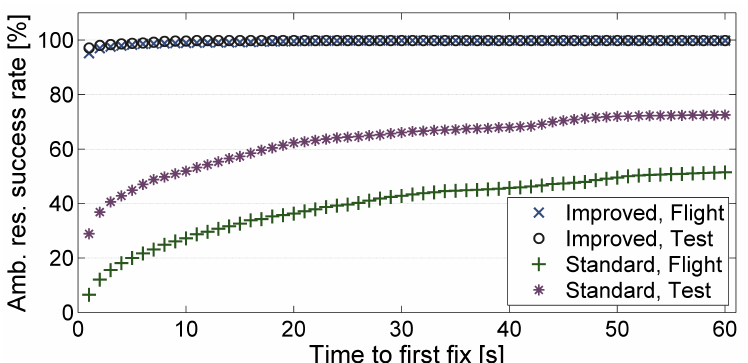
Figure 5. Ambiguity resolution (Amb. res.) success rates after a certain time, determined with a standard ambiguity resolution algorithm (standard) and our ambiguity resolution algorithm (improved) for flight test data (Flight) and test setup data